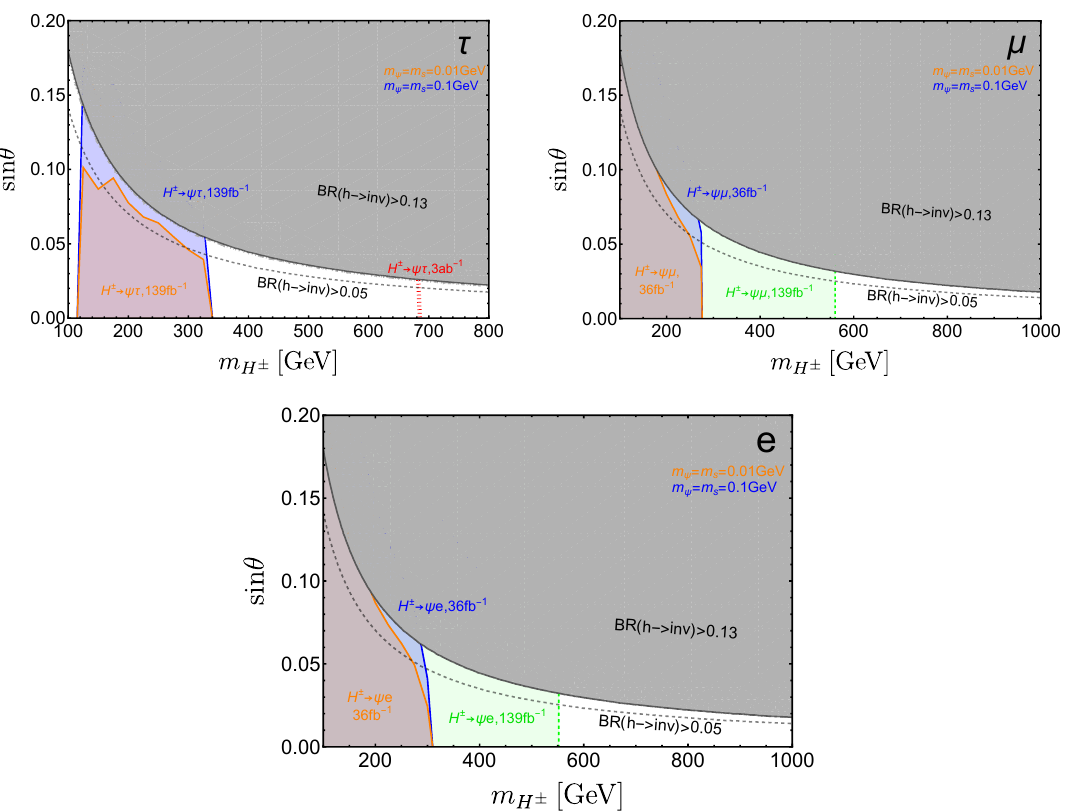
Figure 7 . The collider bounds of the extended model in the ( m Higgs invisible decay bound is shown with gray solid lines and the future prospect at the HL-LHC with gray dashed lines. The orange and blue regions are excluded by the slepton searches with the corresponding luminosity data and assuming m respectively. For the electrophilic and muonphilic cases, the light green regions are excluded with 139 fb − 1 . The HL-LHC prospect of the stau search is shown in a red dashed line and the left of the line will be fully tested. See the main text for further